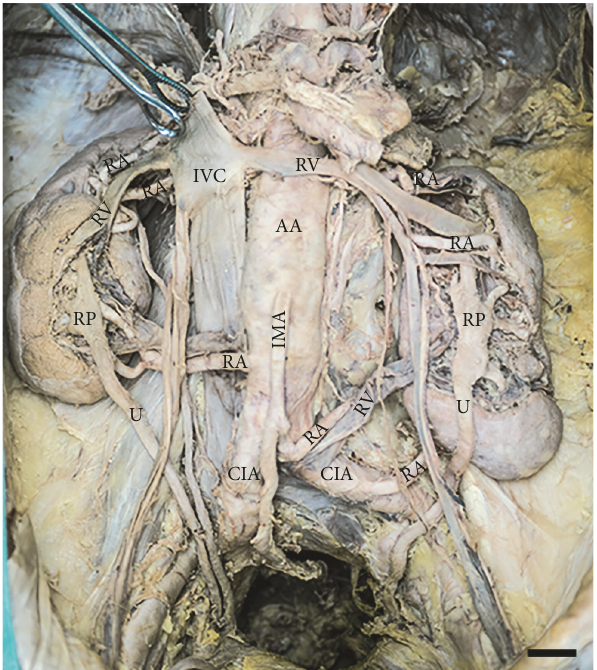
Figure 1: Renal system in situ . Macroscopic view of the renal system within the abdominal cavity of the donor. AA = abdominal aorta, CIA = common iliac artery, IMA = inferior mesenteric artery, IVC = inferior vena cava, RA = renal artery, RP = renal pelvis, RV = renal vein, U = ureter. Image scale bar = 2